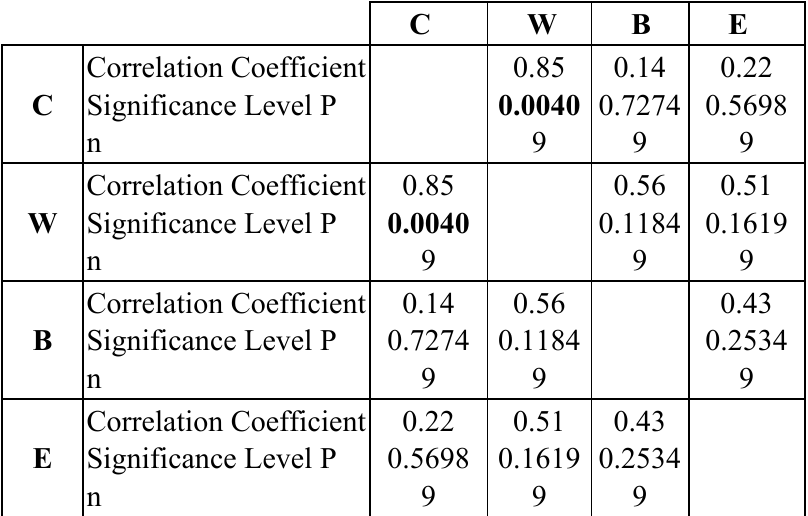
Table 5. Pearson correlation coefficients for duration after discharge values observed for different